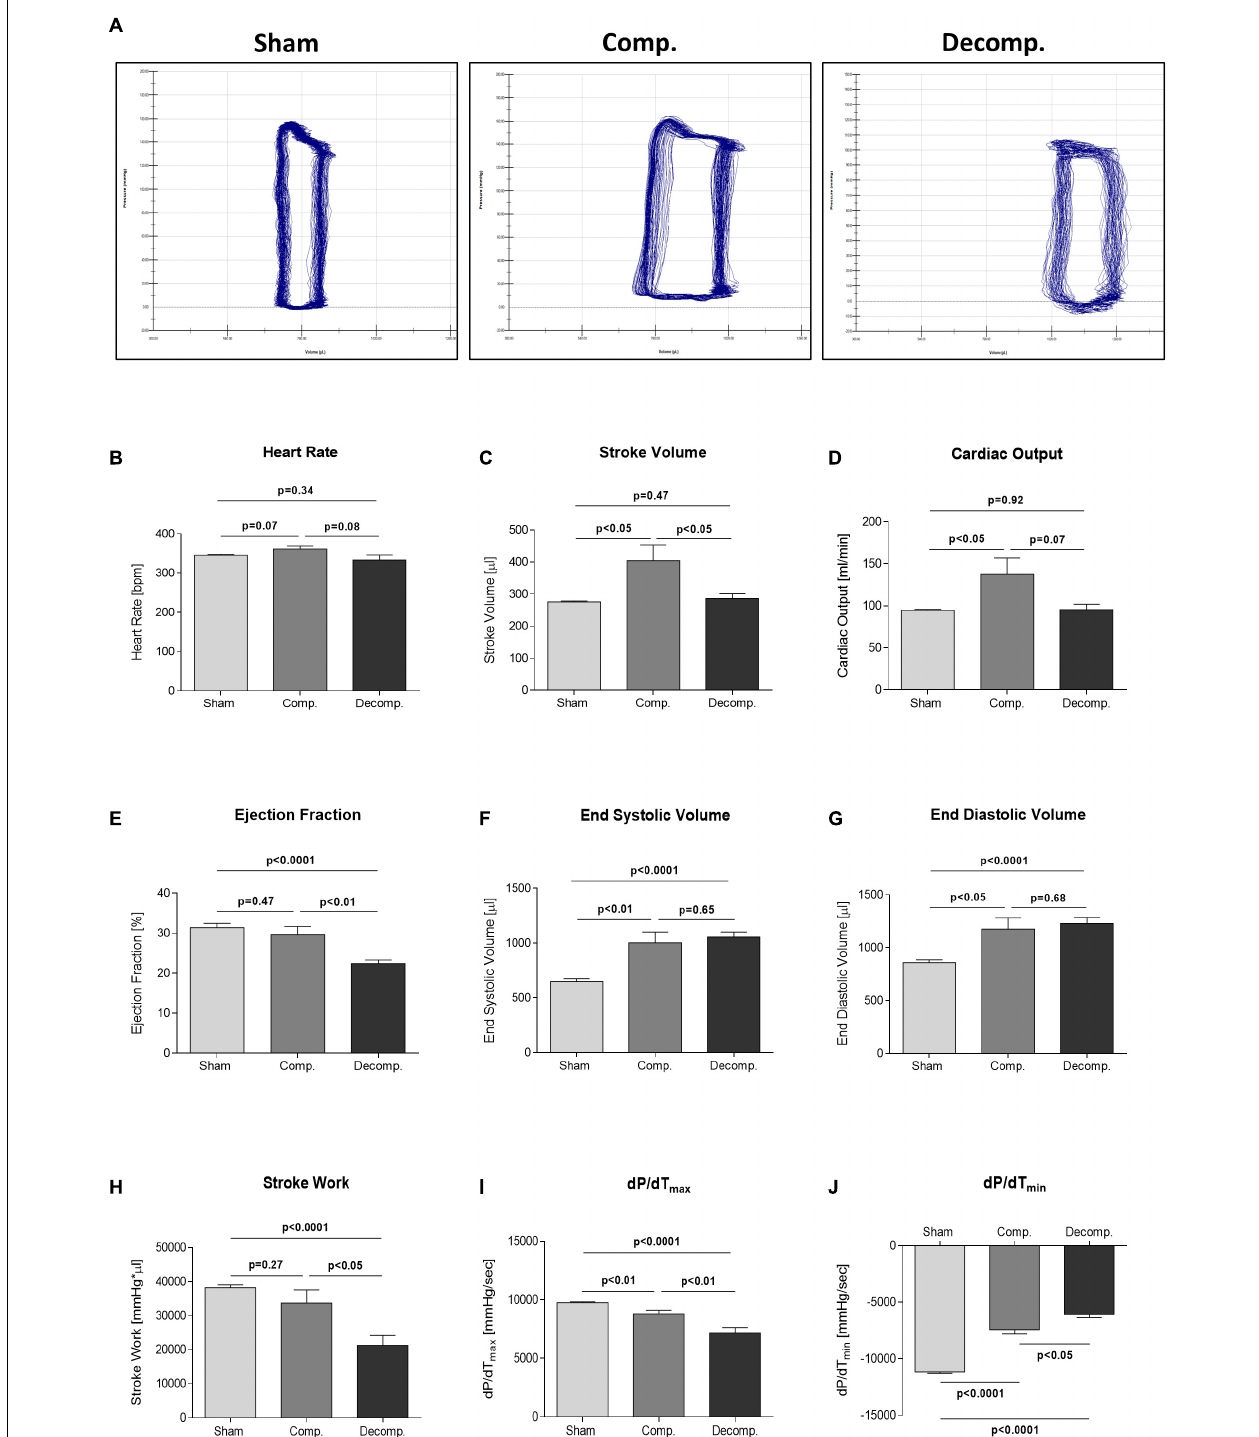
FIGURE 1 | Pressure-volume loops in compensated and decompensated CHF and their sham controls. (A) Representative pressure-volume loops of rats with compensated CHF, decompensated CHF, and sham controls. (B) Heart rate, (C) stroke volume, (D) cardiac output, (E) ejection fraction, (F) end-systolic volume, (G) end-diastolic volume, (H) stroke work, (I) dP/dT max , (J) dP/dT min . Ejection fraction equals (end-diastolic volume – end-systolic volume)/end diastolic volume. Stroke work is calculated as the area under the pressure-volume curve (volume*pressure product). Maximum and minimum dP/dt signify the maximal systolic pressure generation as a parameter of left ventricular contractility and the minimal diastolic pressure loss as a parameter of left ventricular relaxation capacity, respectively. Values are means ± SEM.